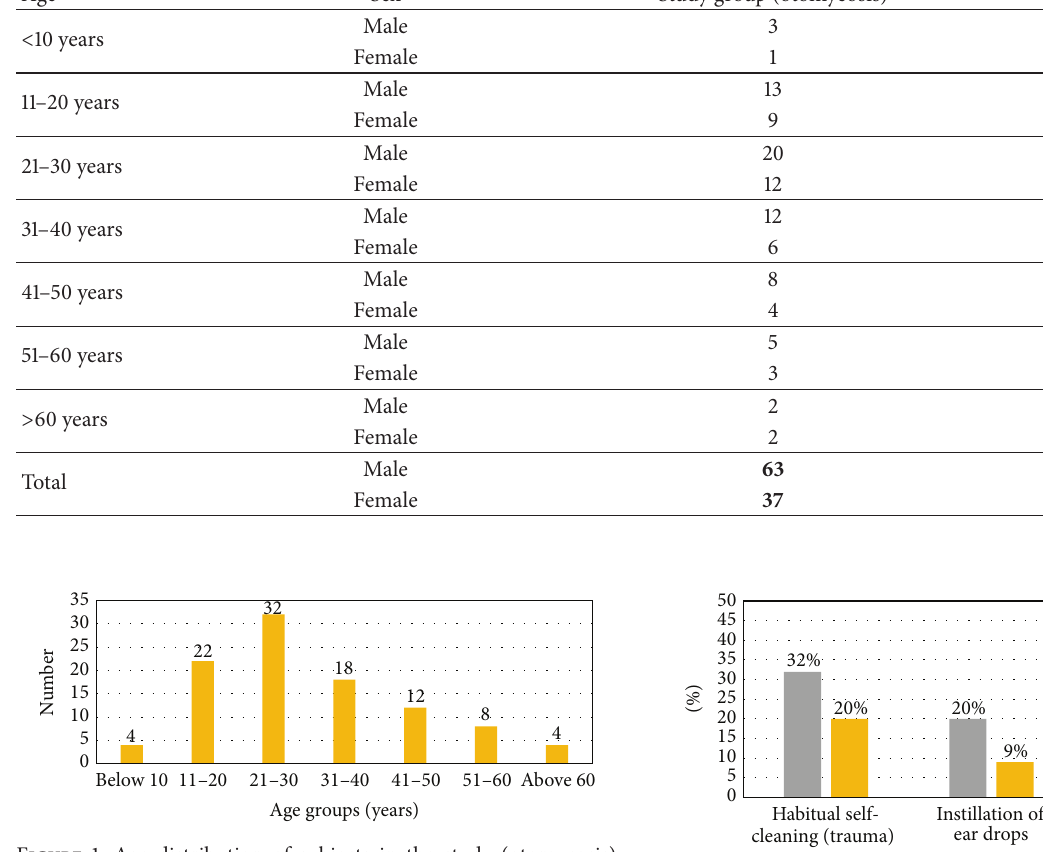
Figure 1: Age distribution of subjects in the study (otomycosis) group.